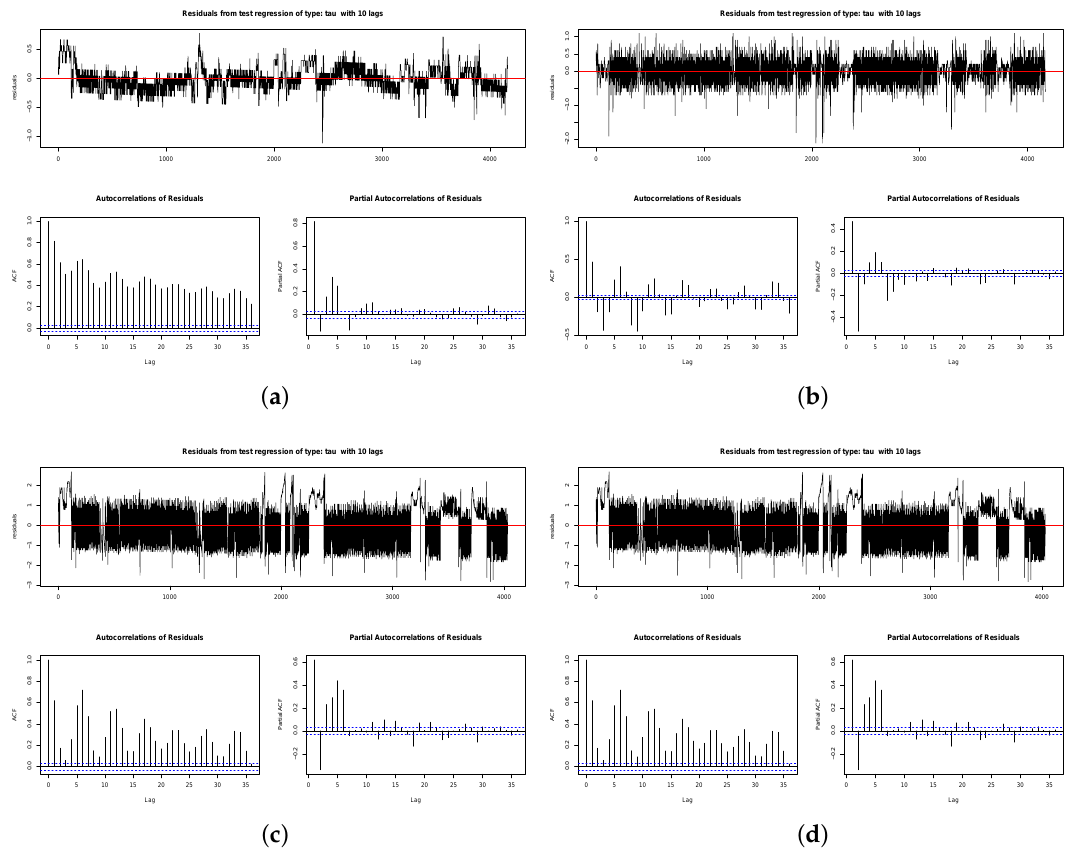
Figure 4. Signal, autocorrelations and partial autocorrelations of residuals: ( a ) TAR sensor. ( b ) TAS sensor. ( c ) TFEU sensor. ( d ) TFSU